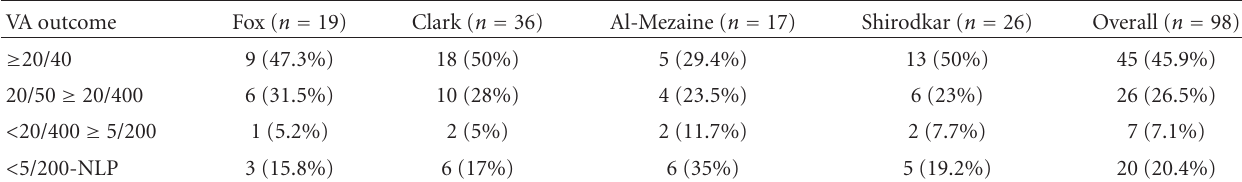
Table 3: Visual acuity outcomes reported in four major series of chronic postoperative endophthalmitis [5, 16, 18, 28].